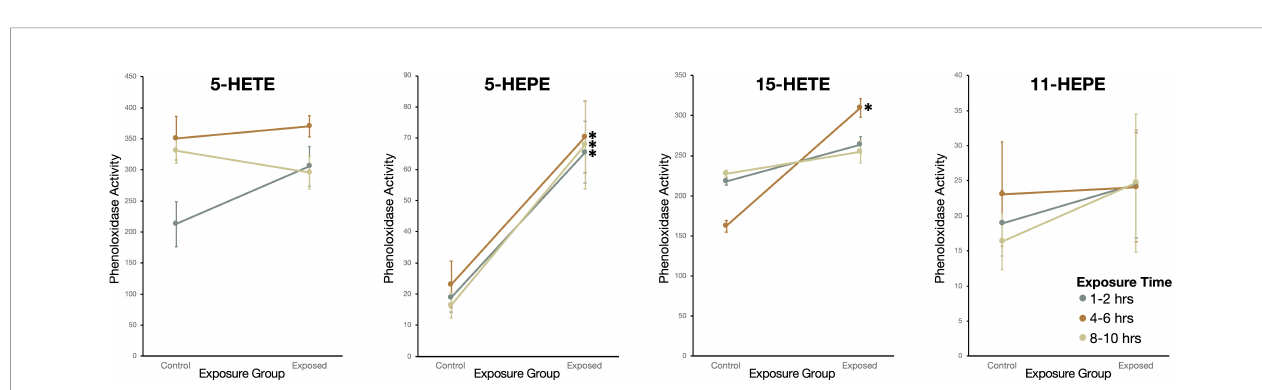
FIGURE 7 | Phenoloxidase (PO) activity (change in absorbance over 2hr measured in kilounits; mean ± SE) of haemolymph in Stagnicola elodes snails exposed to 5-Hydroxyeicosatetraenoic acid (5-HETE), 5-Hydroxyeicosapentaenoic Acid (5-HEPE), 15-Hydroxyeicosatetraenoic acid (15-HETE), and 11-hydroxy- 5Z,8Z,12E,14Z,17Z-eicosapentaenoic acid (11-HEPE) oxylipins compared to sham-exposed snails. * P <